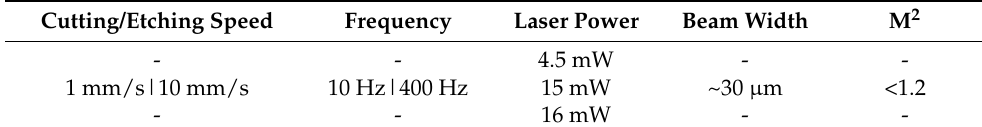
Table 3. Laser texturing process parameters.